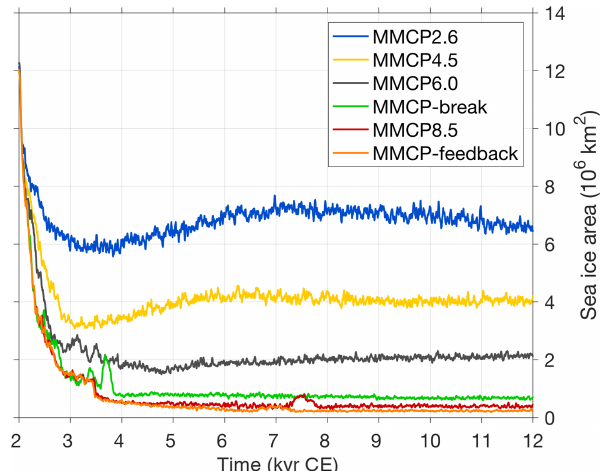
Figure 3. Mean sea-ice area evolution in the Southern Ocean for the six different forcing scenarios.